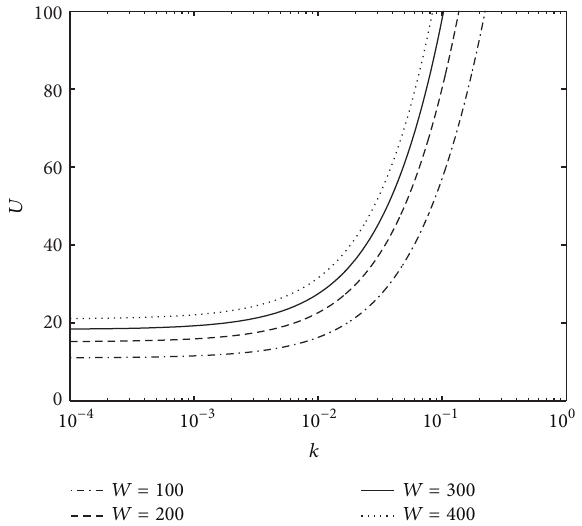
Figure 2: The neutral curves of velocity ratio for the different values of Weber number when 𝐸 = 0 , 𝜇 = 0.018 , 𝜌 = 0.0012 .